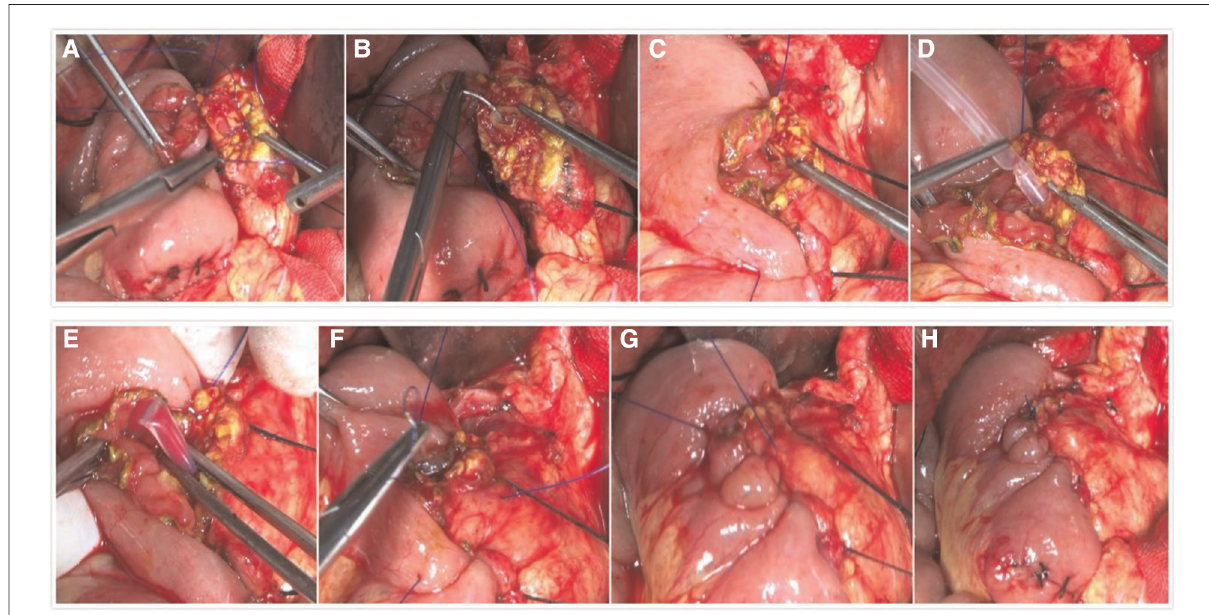
FIGURE 1 Intraoperative photographs of the novel end-to-side one-layer continuous pancreaticojejunostomy. ( A ) Perform all-layer continuous inverting suture between pancreatic margin and jejunal from the rear edge of the pancreas start with a 2-0 Prolene slip line. ( B ) Sew 2 – 3 stitches in the rear wall of the pancreatic duct and the posterior tissue together with the whole layer of the jejunum. ( C ) The suture of the rear wall is completed. ( D ) Build a support tube into the main pancreatic duct. ( E ) Put the support tube into the jejunum. ( F ) Turn to the front edge from the rear edge and sew the front edge of the pancreas and the other side of the jejunum with whole-layer suturing. ( G ) Take up the line. ( H ) Knot and complete